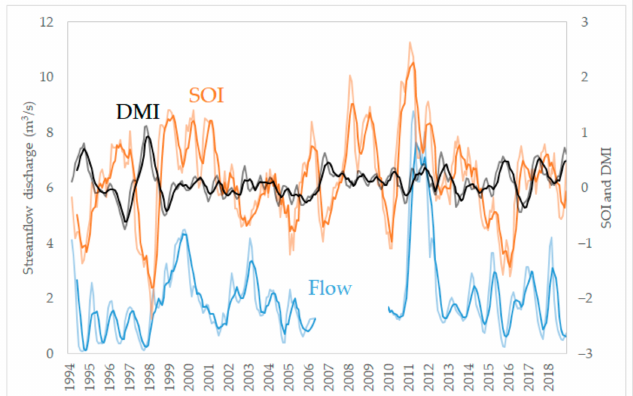
Figure 2. Time series of Code River downstream flow, Southern Oscillation Index (SOI), and Dipole Mode Index (DMI), with a 6-month moving average and 3-month moving average (light color). The streamflow data of the years 2006 to 2009 are